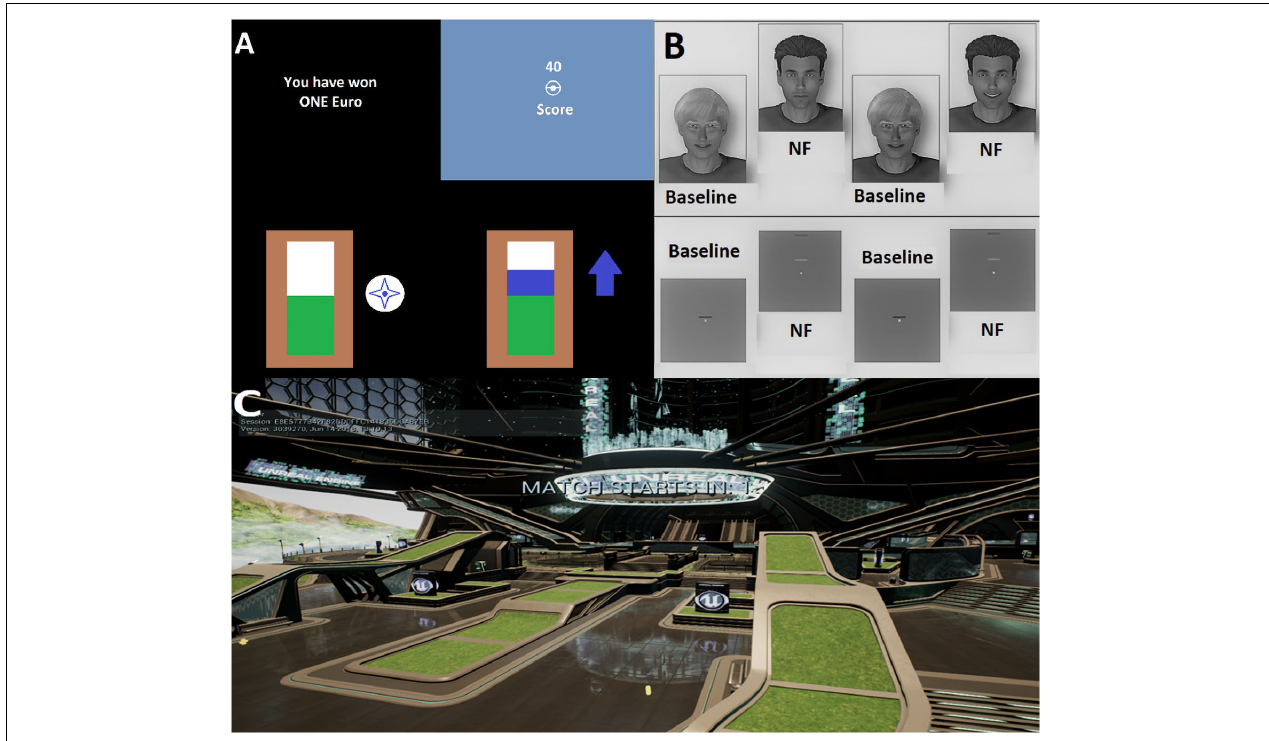
FIGURE 1 | (A) An overview of current methods used as NF modalities (Bray et al., 2007; Rota et al., 2009; Ruiz et al., 2013). These images have been modified and reimagined from the original and grouped together to concisely show the general NF visualizations. (B) Social reward via NF paradigm (Mathiak et al., 2015). This image has been converted to a gray-scale color scheme from the original. (C) An overview picture of our current implementation of the virtual environment as an NF modality. Original environment modified from Epic Games’ project titled “Shooter Game.”